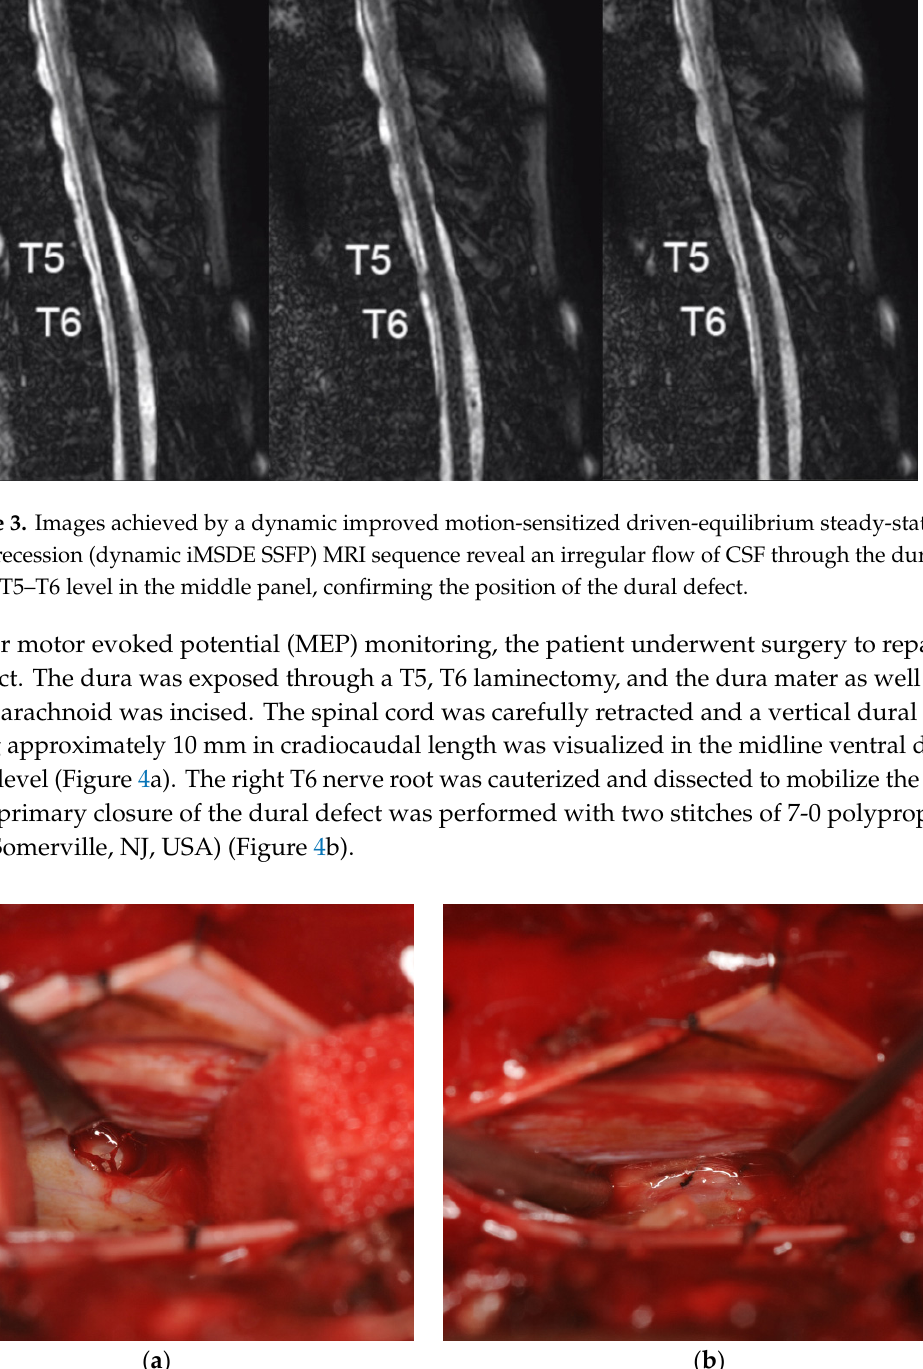
Figure 2. A balanced turbo field echo (BTFE) MRI sequence, which achieves rapid and high-resolution imaging of the spinal anatomical structures, reveals a gap in the anterior dura mater at the T5–T6 level. ( a ) sagittal-, and ( b ) axial-oriented images.